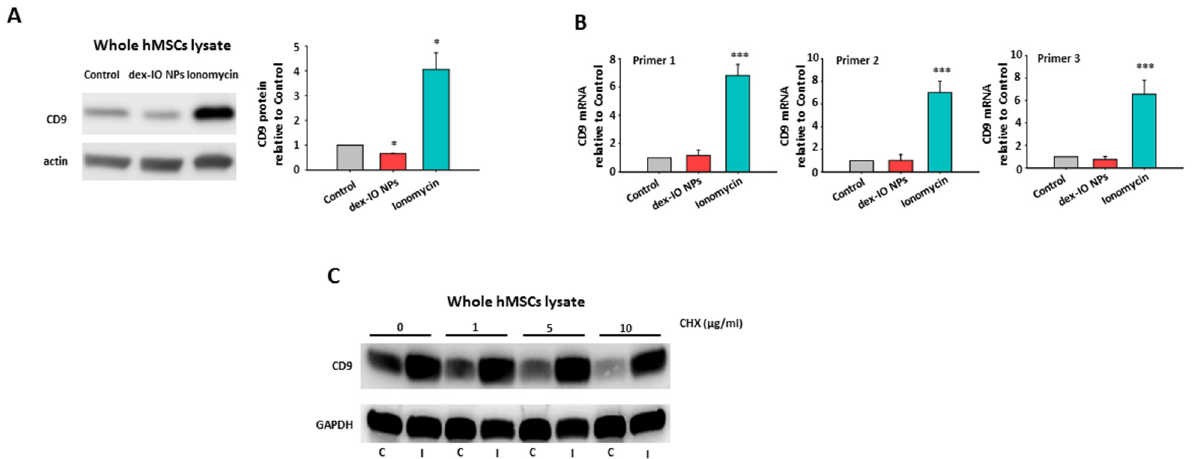
Figure 6. Ionomycin but not dex-IO NPs increased cellular CD9 expression via increasing CD9 transcript and protein stabilization. After treatment of hMSCs without (Control) or with dex-IO NPs for 1 h or ionomycin for 30 min, followed by wash, hMSCs were grown for 24 h and analyzed by Western blot for cellular CD9 protein ( A ) and RT-PCR for cellular CD9 mRNA ( B ). Western blot images are shown as representative of at least three independent experiments with similar results. * p < 0.05 as compared with Control. The relative CD9 mRNA levels are presented as the mean ± SEM of three independent experiments. *** p < 0.001 as compared with Control. ( C ) Cycloheximide (CHX) displayed a dose-dependent degradation of CD9 expression in hMSCs. Ionomycin antagonized CHX-dependent degradation of CD9. C: Control; I: ionomycin. GAPDH was used as a loading control. Data are representative of at least three independent experiments with similar results.